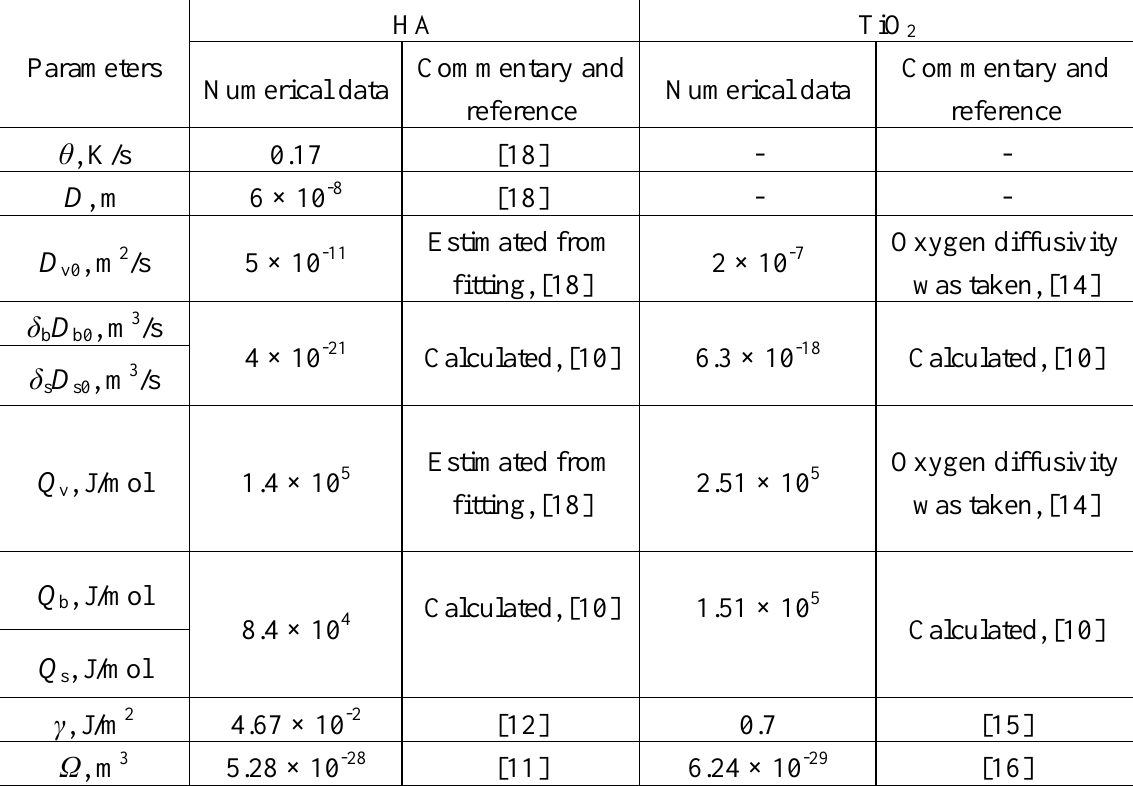
Table 3. Numerical data used for calculation of sintering